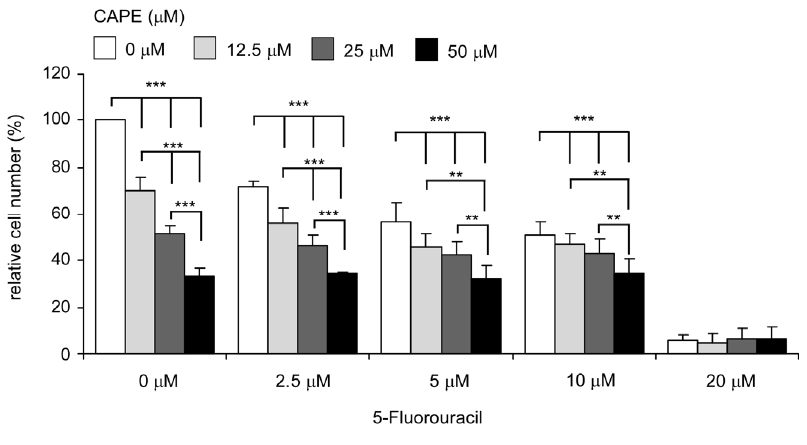
Figure 7. Co-treatment of CAPE and 5-fluorouracil exhibited additive suppression effect on proliferation of TW2.6 cells. TW2.6 cells were treated with increasing concentrations (0, 2.5, 5, 10 and 20 μ M) of 5-fluorouracil in the presence of various concentrations (0, 12.5, 25, 50 μ M) of CAPE for 48 h. Proliferation of TW2.6 cells was determined by Hoechst dye-based 96-well proliferation assay. Cell number was normalized to control (DMSO treatment only). Experiments were repeated three times. Error bars represented standard deviation. The mean and standard deviation represented the average and standard deviation respectively of the results from all 36 wells in the three experiments. Asterisk ( *** ) represents statistically significant difference ( p < 0.001) between the treated group and the control